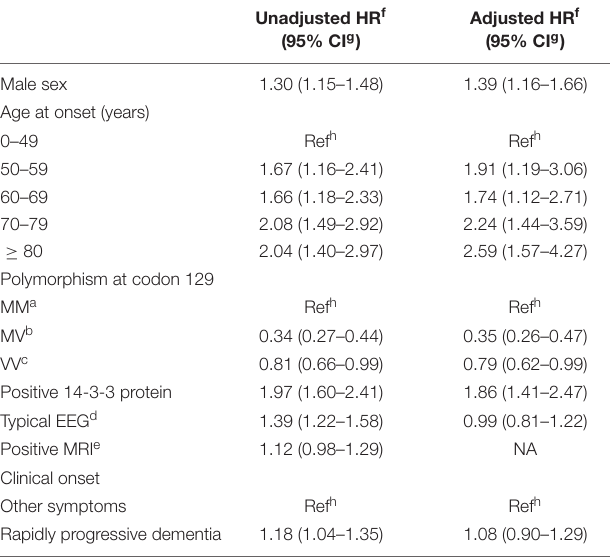
TABLE 3 | Univariate and multivariate Cox regression analysis for sporadic cases ( n =